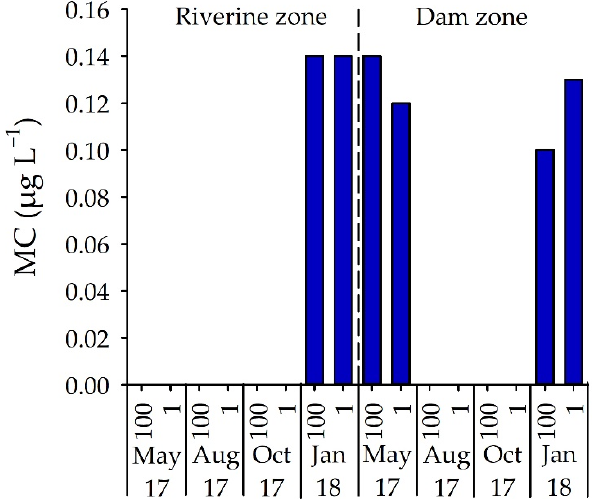
Figure 6. MC concentration ( µ g L − 1 ) in samples from two field stations, in four months and two depths in Itupararanga reservoir. 100 = surface; 1 = lower limit of euphotic zone.